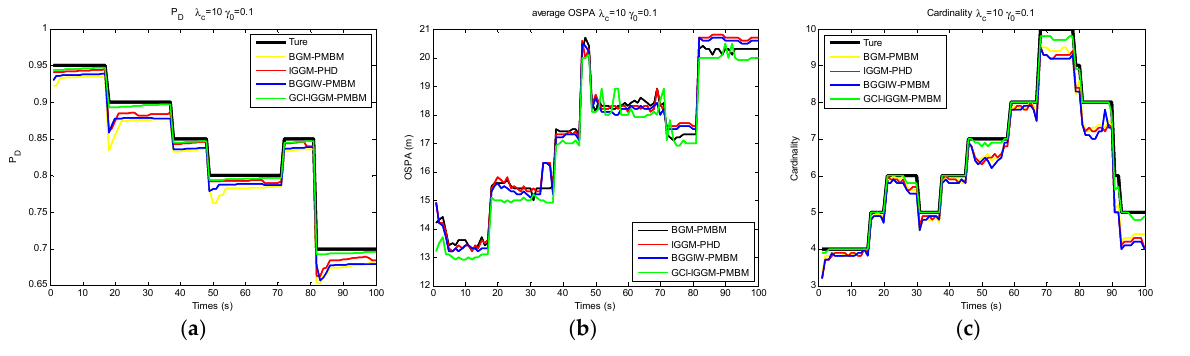
Figure 6. Performance comparisons of GCI–IGGM–PMBM with other multitarget tracking schemes with unknown detection probability: ( a ) detection probability estimation; ( b ) OSPA estimation; ( c ) cardinality estimation.